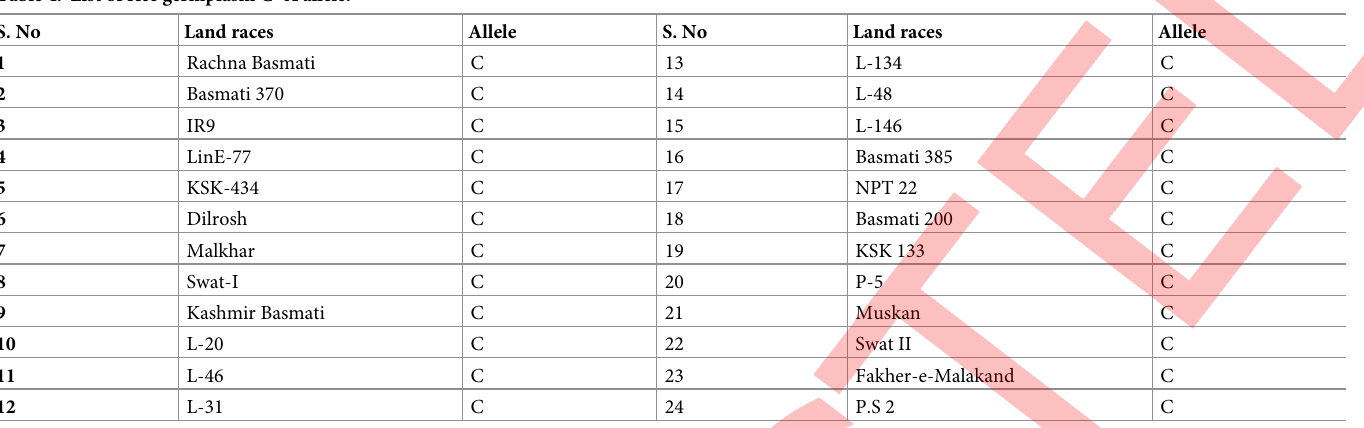
Table 4. List of rice germplasm C- A allele.